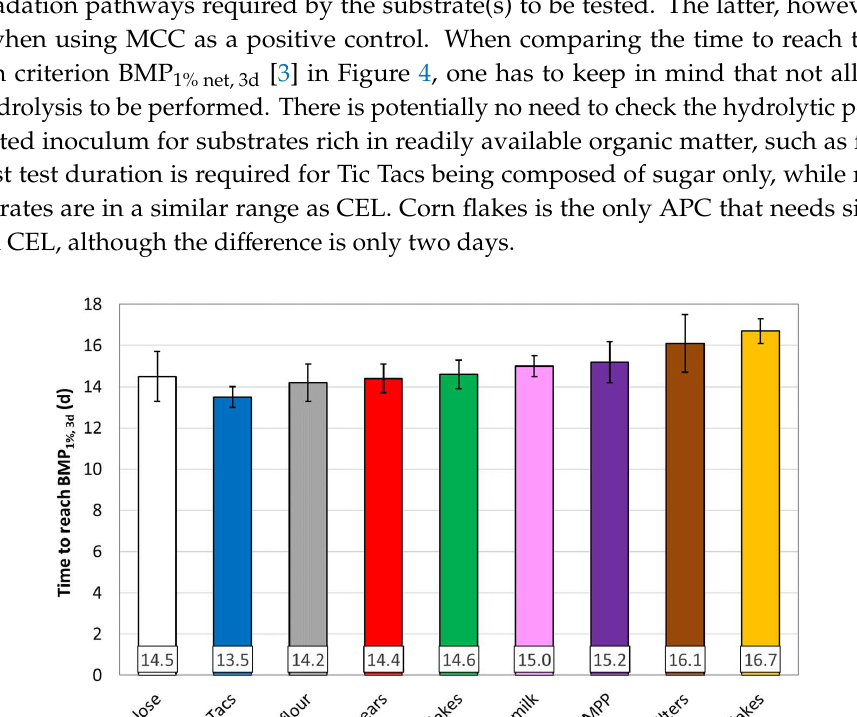
Figure 5. Measured BMP for microcrystalline cellulose and alternative positive control substrates. Error bars indicate standard deviation ( n = 9 for microcrystalline cellulose and n = 3 for all other substrates). Values have been sorted in ascending order. 3.4. Overall Assessment An ideal positive control is characterized by a high and fast anaerobic degradability (i.e., considerable methane production and reasonable time to reach the termination criterion) and a high reproducibility (i.e., low standard deviation among the replicates), while ideally checking all degradation pathways the substrate(s) to be tested require. As most guidelines recommend CEL as a positive control independent from the substrate to be tested [2–4,11], future attempts to improve existing guidelines should take this into account. Table 2 summarizes the most important findings. The time to reach BMP 1% net, 3d was relatively similar for all substrates tested and ranged between 13.5 and 16.7 days. On average, 353 L CH4 /kg VS was recovered from CEL, which corresponds to 85% of the